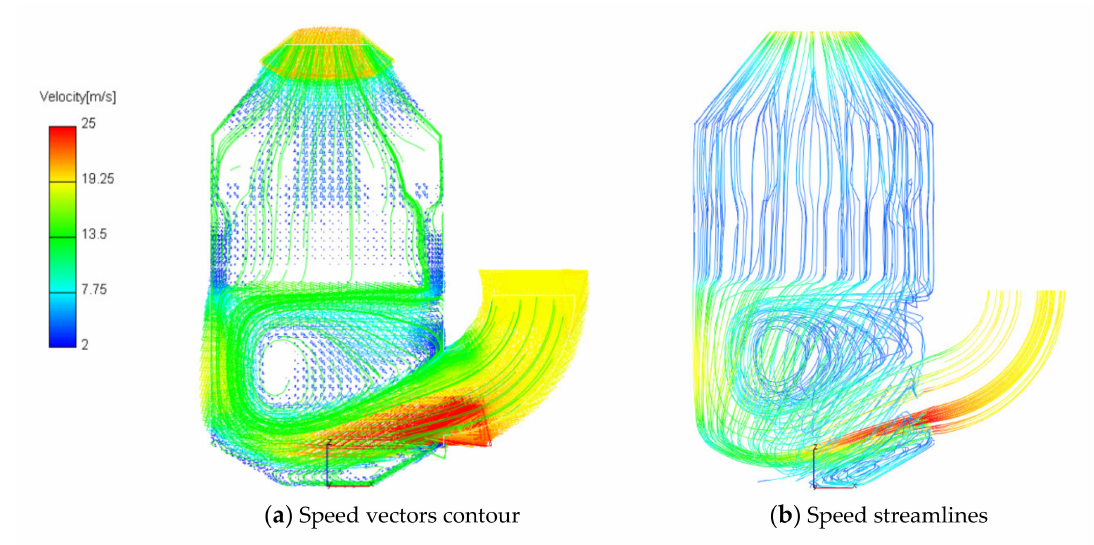
Figure 6. Speed vectors contour and streamlines inside the